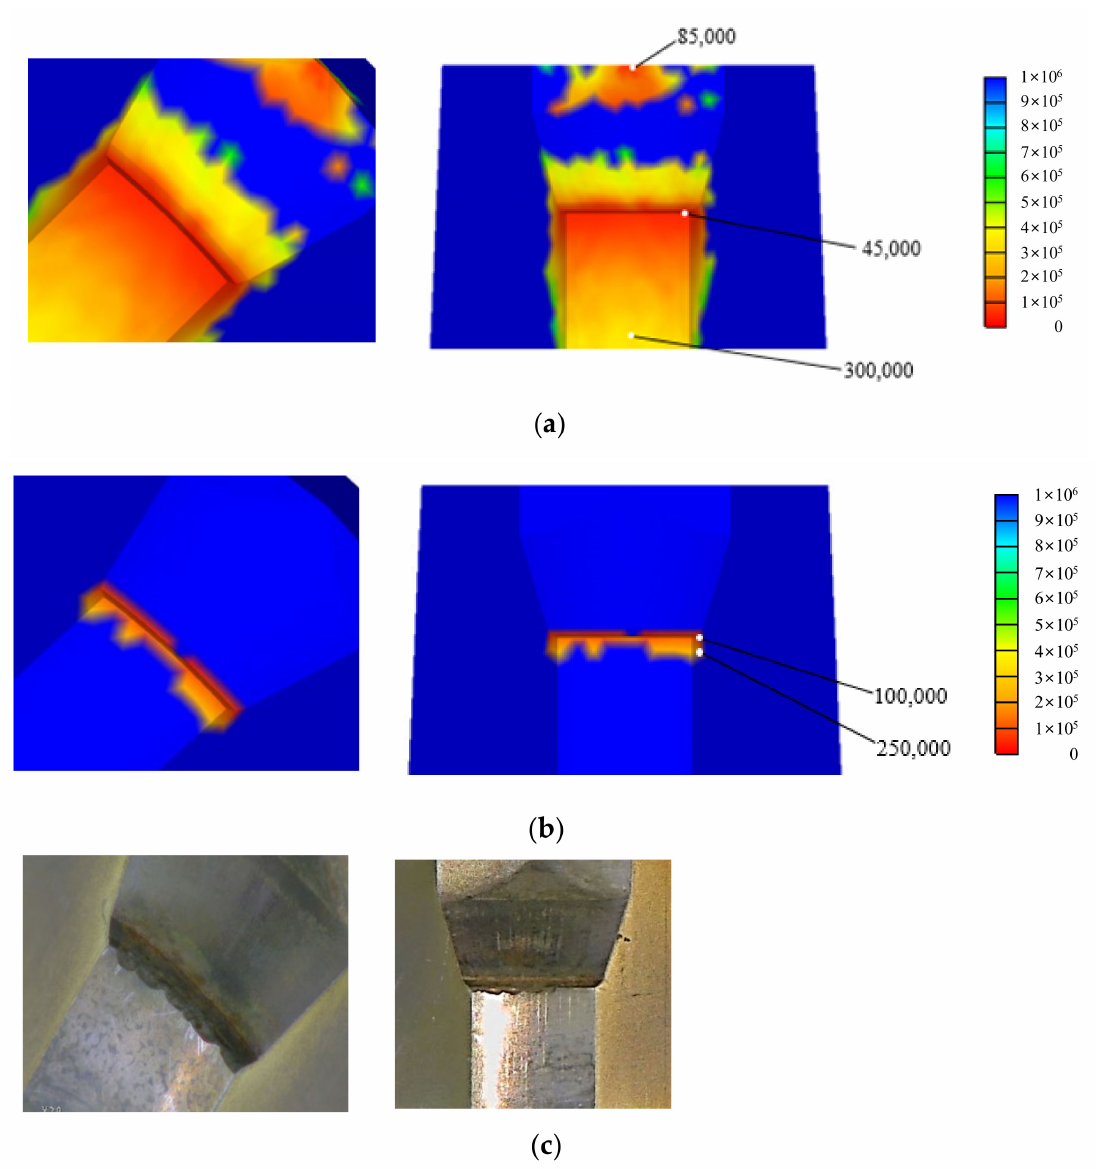
Figure 15. Predicted HCF life of the die insert (marked by S) involved in nut-forming: ( a ) Goodman– Haigh model; ( b ) Our model; ( c ) Fractured